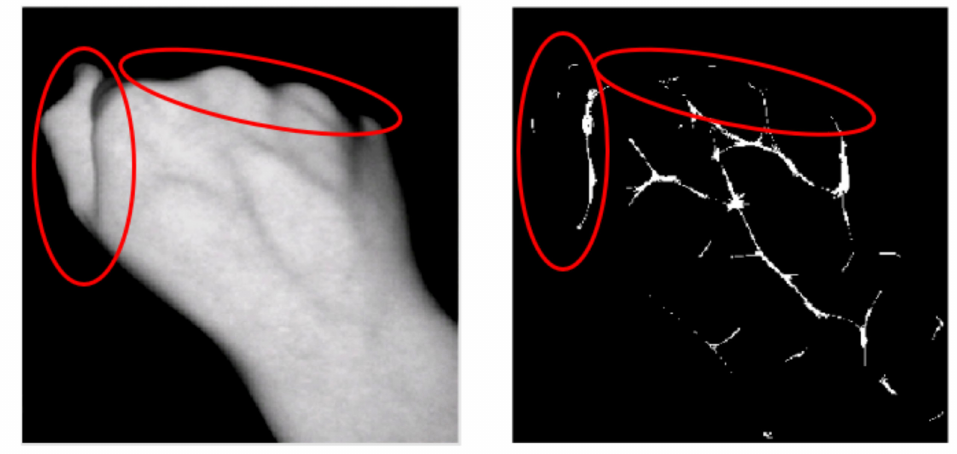
Figure 6. Maximum Curvature features ( right ) extracted from a vein image acquired under indoor natural light 2 condition ( left ). Features outside the ROI are indicated by red ellipses.